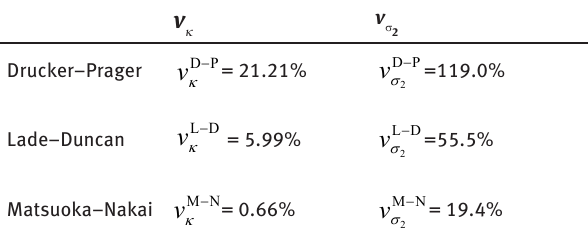
Table 6: The linear fits κ exp (